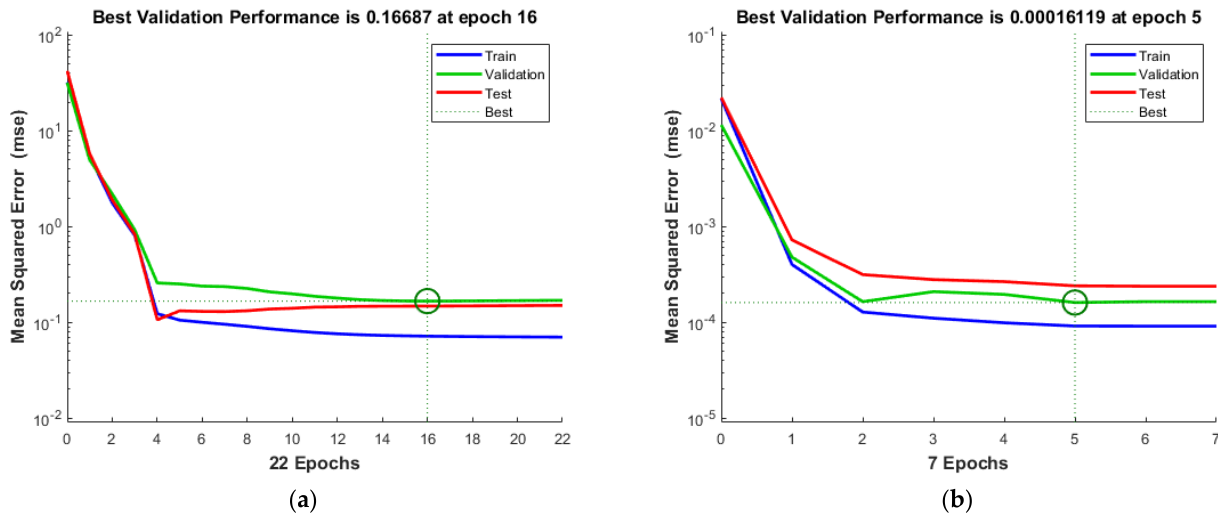
Figure 12. Performance of the trained networks: ( a ) ANN1 and ( b ) ANN2. Error histograms are presented in Figure 13. The error ranges from − 1.451 to 1.796 for ANN1 and from − 0.032 to 0.025 for ANN2. Analysing the first one (Figure 13a), outliers at the extreme sides of the graph are negligible. Most of the data used for training, validating, and model testing are centred in the histogram, close to the zero-error line. In the case of Figure 13b, the errors are instead more widely distributed within the interval.